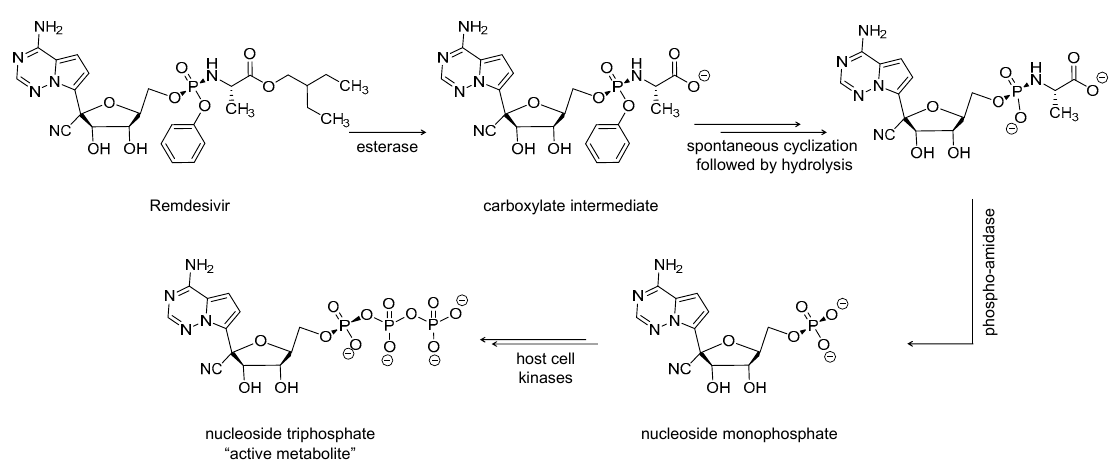
Figure 2. Chemical structure of remdesivir and schematic representation of its metabolic bioactivation. Remdesivir is adenosine monophosphate derivative; it is also classified as nucleotide prodrug. The corresponding triphosphate form is the active form and it is the inhibitor of the viral RNA polymerase. Remdesivir itself demonstrated in vitro activity against Vero E6 cells infected with SARS-CoV-2 with an EC 50 value of 0.77 µ M (CC 50 > 100 µ M) [33]. Remdesivir also exhibited in vitro